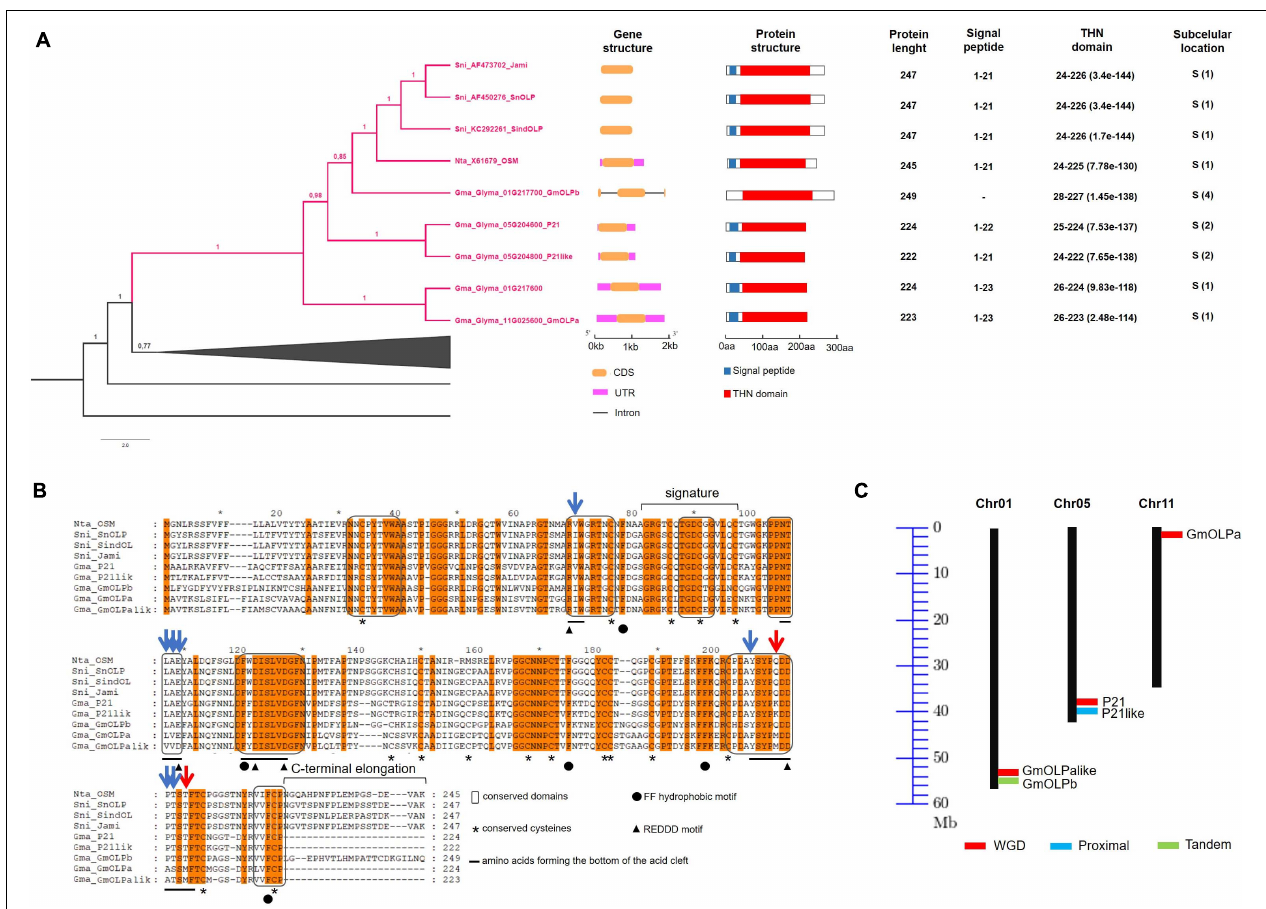
FIGURE 1 | Osmotin in silico analysis. (A) Detailed representation of the phylogenetic relationship among the thaumatin domain within the osmotin monophyletic clade with corresponding gene and protein structure information. According to the phylogenetic results the Gma_Glyma_01G217600 protein was named GmOLPa-like. Subcellular locations are numbered according to the TargetP server from one to five, where one indicates the strongest prediction. S, secretory pathway. (B) Alignment of osmotin protein sequences. Conserved residues and protein secondary structure are indicated according to Petre et al. (2011). Orange letter background corresponds to conserved amino acids (aa) among the nine analysed sequences. Blue and red arrows indicate aa substitutions with similar and different properties, respectively. (C) Chromosomal location and duplication of soybean osmotins. Black vertical lines represent the chromosomes with their numbers at the top. WGD, whole-genome